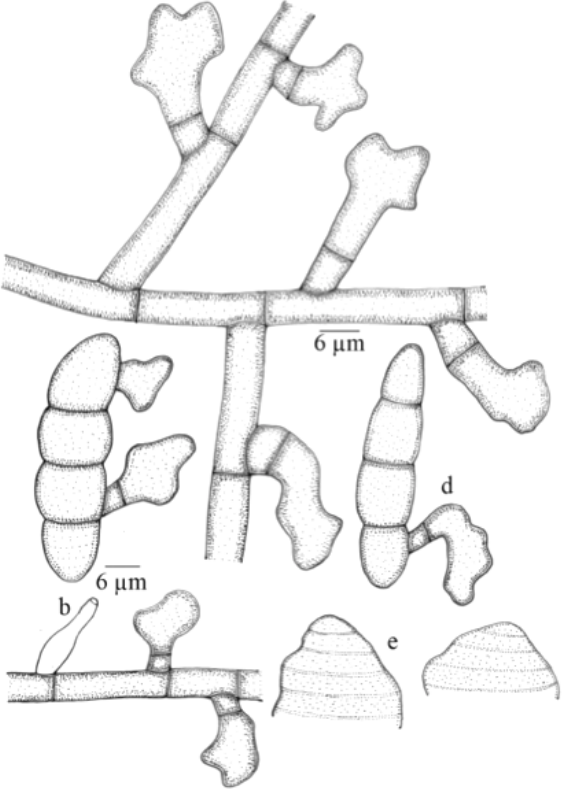
Figure 7. Appendiculella calostroma a - Appressorium; b - Phialide; d - Ascospores; e - Perithecial appendages